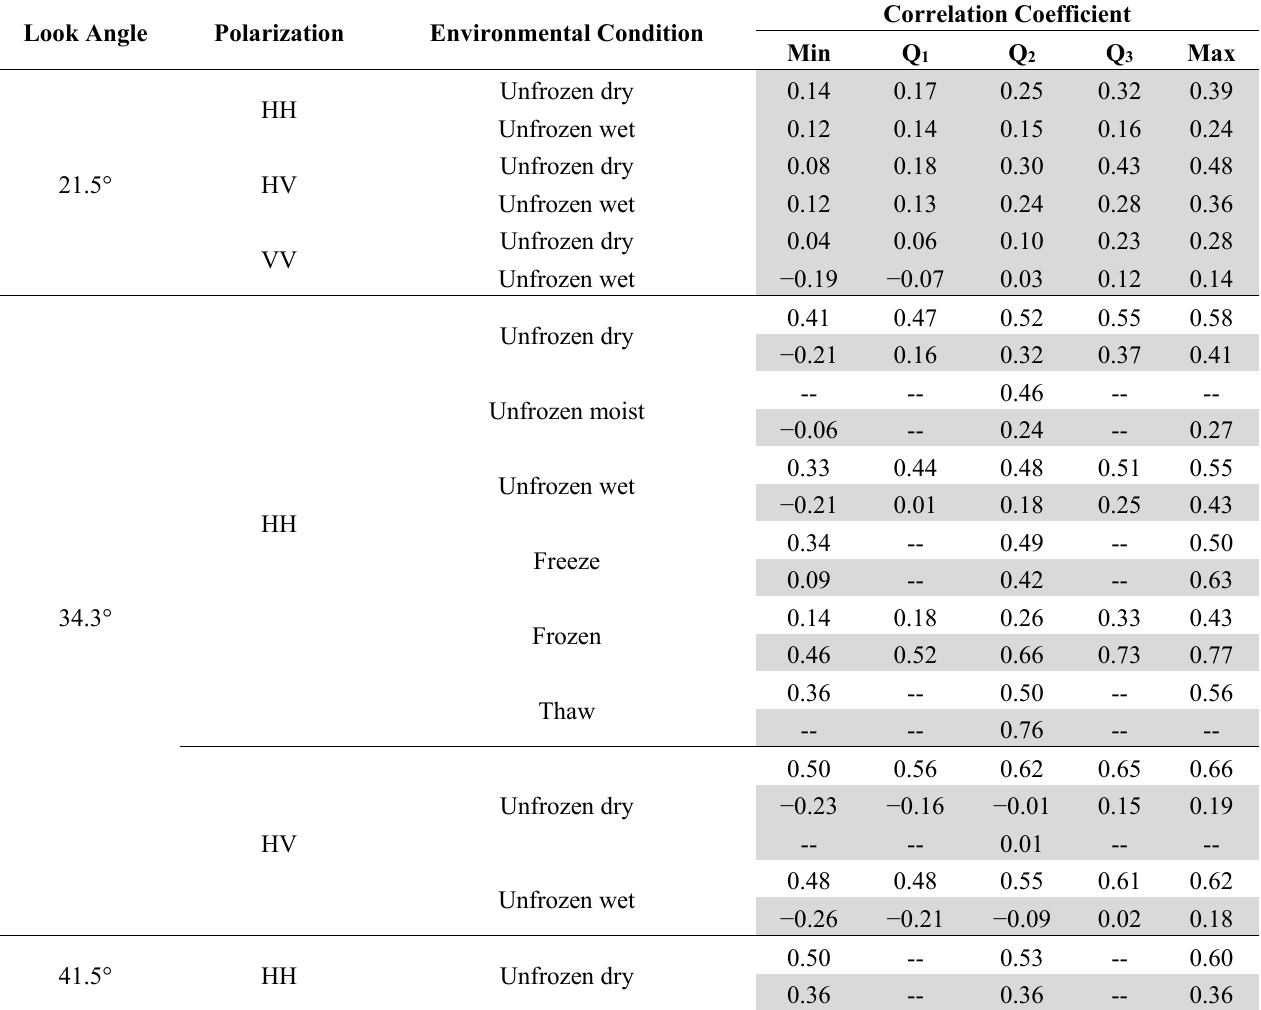
Table 5. Distribution of the Pearson's correlation coefficient between stem volume and SAR backscatter for a given combination of look angle, polarization and environmental condition. Combinations are listed consisting of at least three PALSAR datasets. The minimum (Min), three quartiles (Q 1 , Q 2 and Q 3 ) and the maximum (Max) are listed. For combinations with three datasets, only Q 2 is given. For combinations including four or five datasets, only Min, Q 2 and Max are given. Transparent cells refer to Krycklan and shaded cells to Remningstorp. Look Angle Polarization Environmental Condition